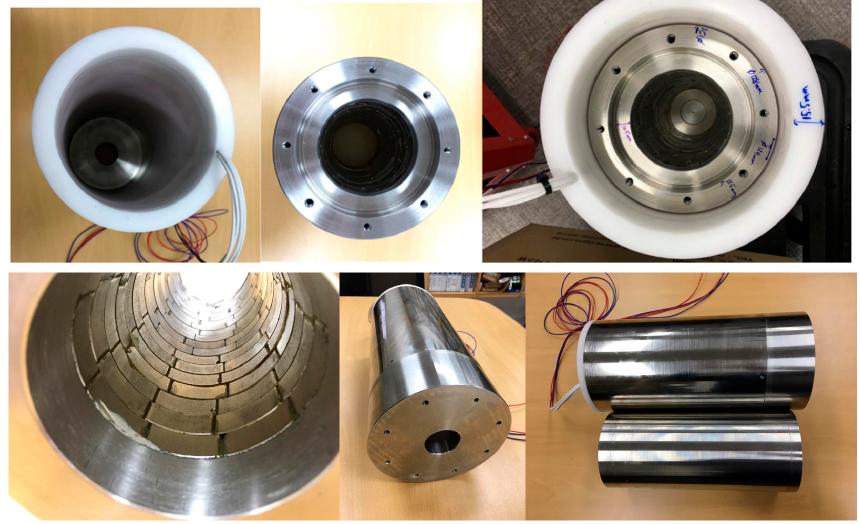
Figure 3. Prototype. Figure 3.